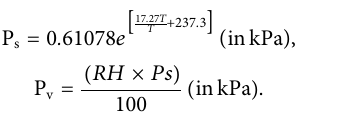
Frontiers in Built